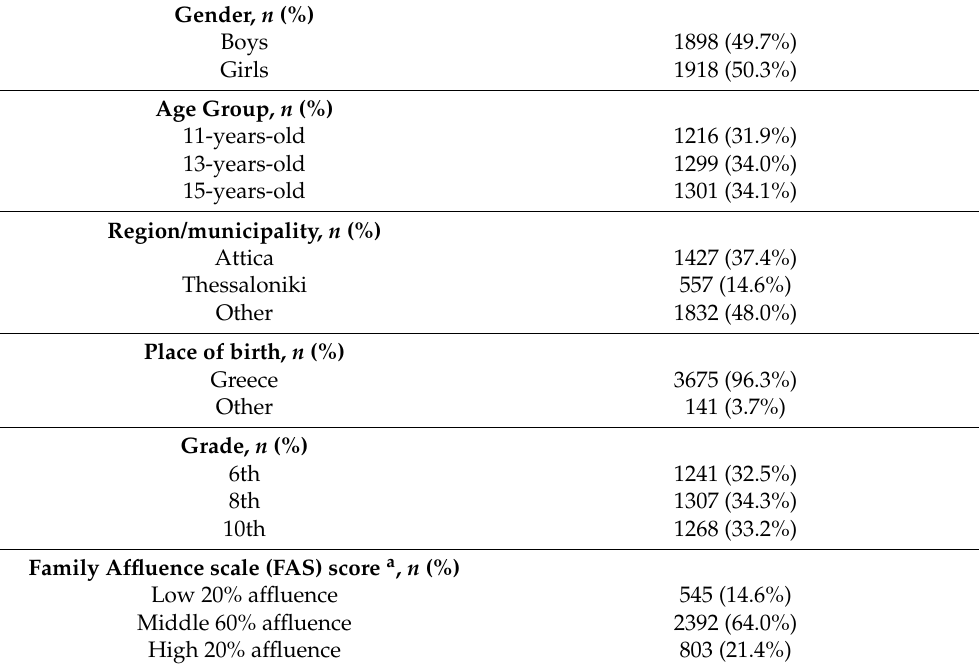
Table 1. Sociodemographic characteristics of 3816 participants in the 2018 Greek arm of the HBSC * study.